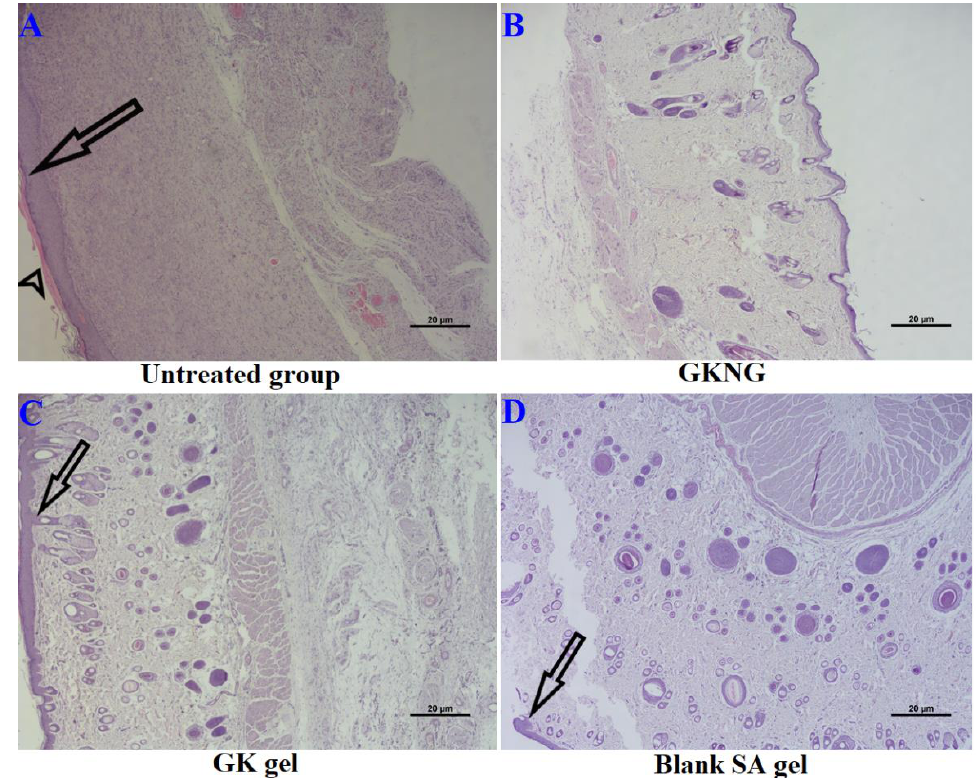
Figure 9. Histopathological analysis of different treatment groups in wound healing on day 20. Subfigure ( A ) is untreated, ( B – D ) have been treated with GKNG, GK gel and Blank SA gel. GKNG treatment exhibited the most potent wound healing potential followed by GK gel and Blank SA gel, as evident with a long and short black arrow representing severe acanthosis and focal hyperkeratosis. Scale bar 20 µm at 40×.